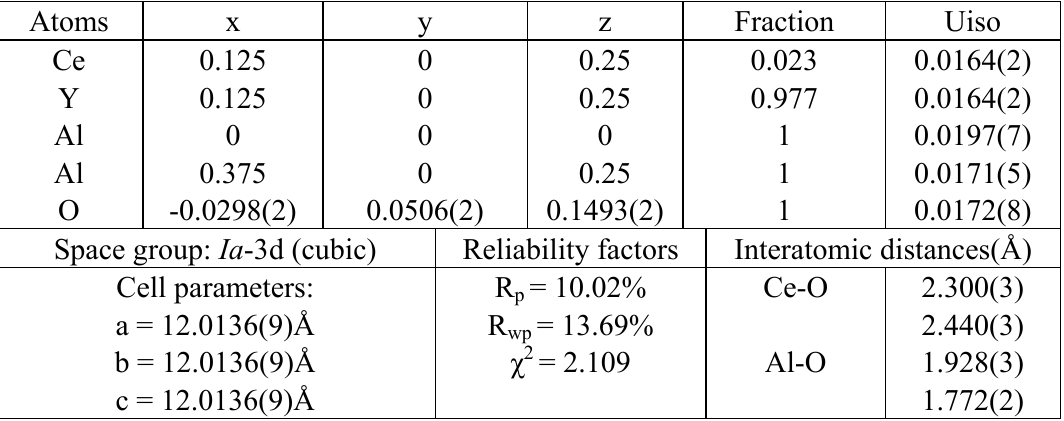
Table 1. Crystallographic Data of (Y